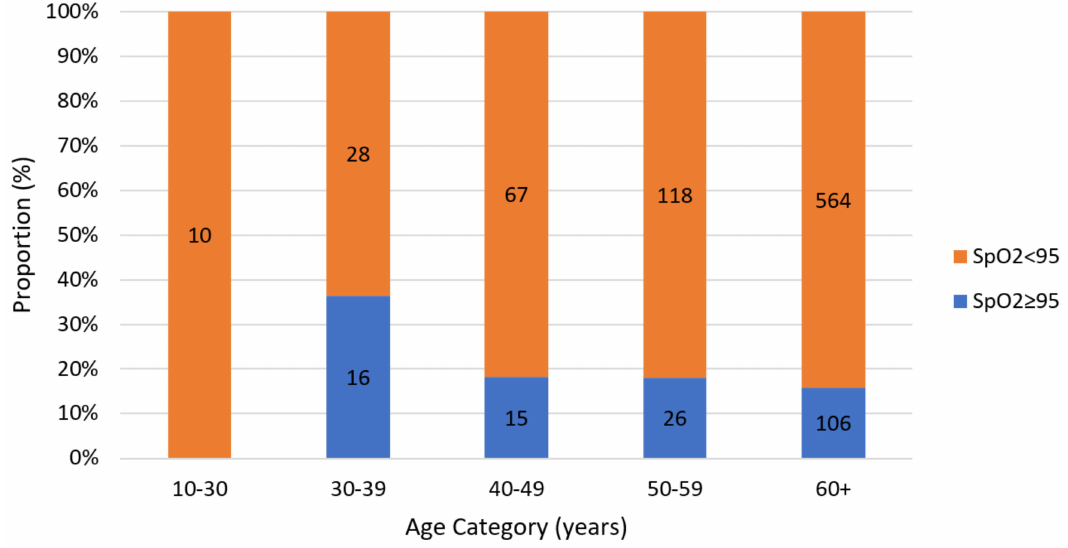
Figure 1. SpO2 level in COVID-19 hospitalised patients’ mortality by age group.